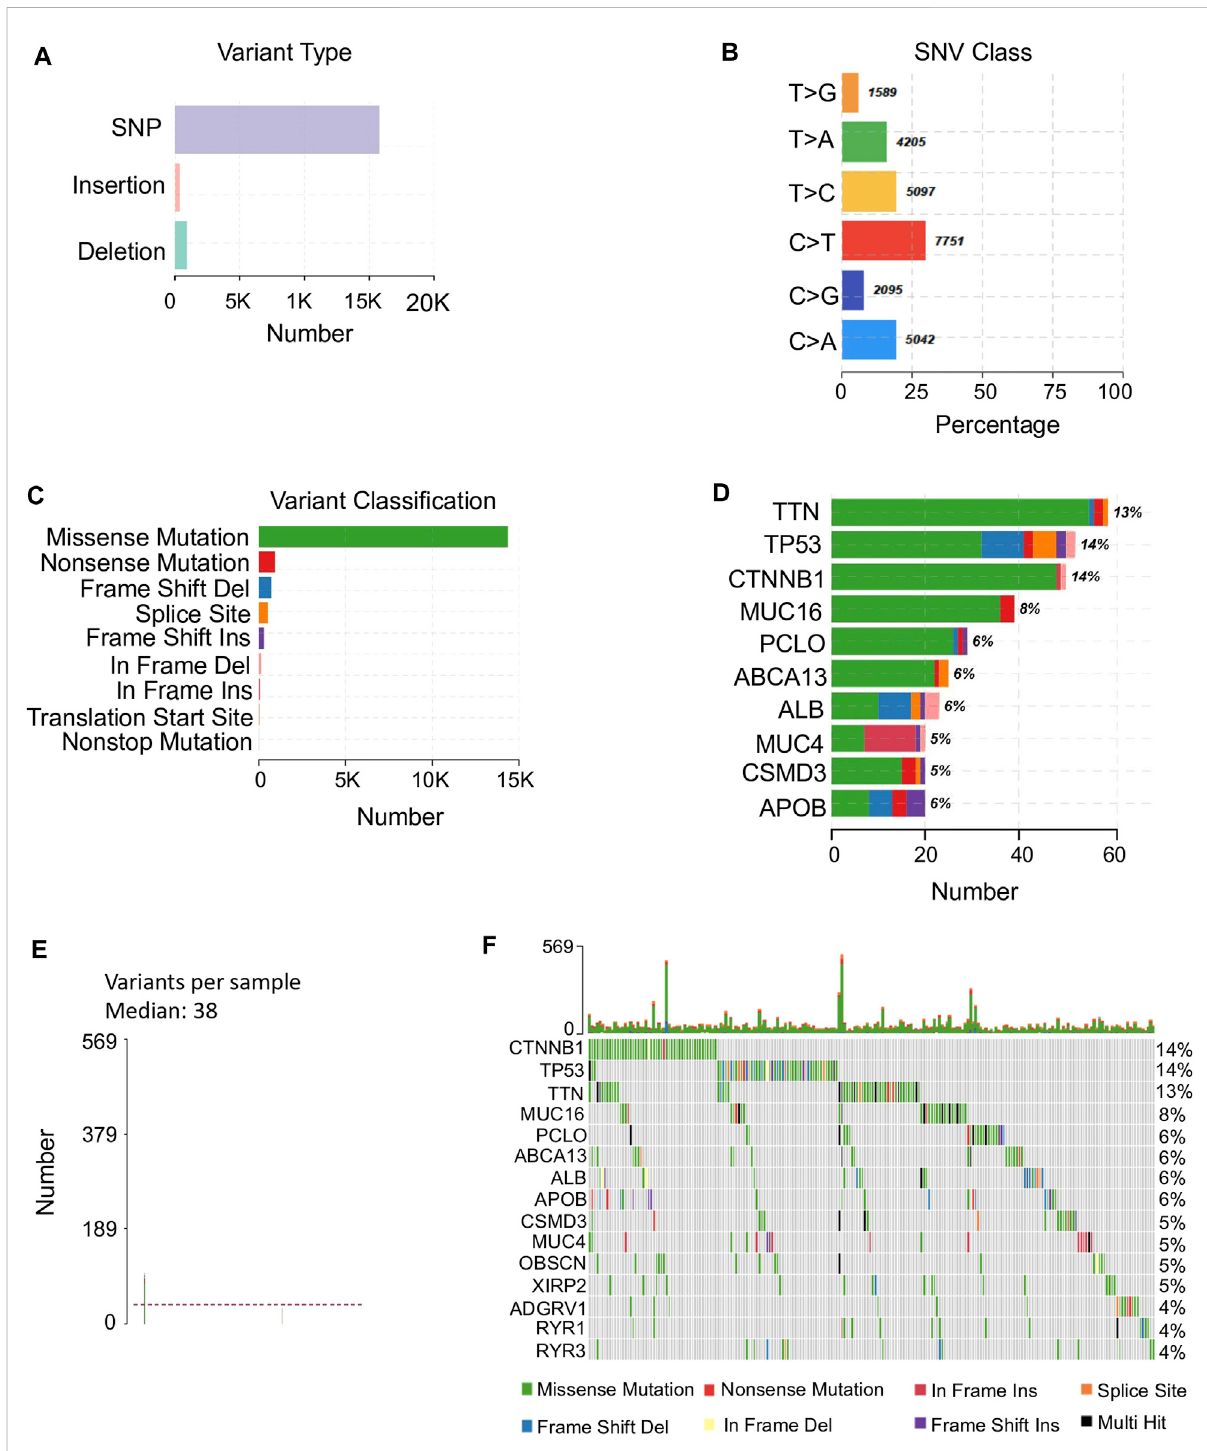
FIGURE 1 Mutation pro fi les in HCC. (A) Major variant types found in HCC representing in y-axis and the corresponding count representing in x-axis. (B) ThepercentageofthemajorSNVclassesidenti fi edinHCCsamples.SNVclassesarepresentediny-axis.ThepercentageofeachSNVtypeisinx-axis and the count is shown beside each bar. (C) The variant classi fi cation and their counts in HCC. (D) The top 10 mutated genes with their variant classi fi cations. The color of classi fi cation is referred to (C) . The percentage of patients with each mutated gene is beside each bar. (E) The medianofvariantspersampleis38amongHCCsampleswithmaximumofvariants569. (F) Detailedinformationofthetop15mutatedgenesamong 363 HCC patients. The upper panel illustrates the number of mutations of these top 15 genes of each sample shown in bar chart and the percentage of each mutated gene is shown on the right